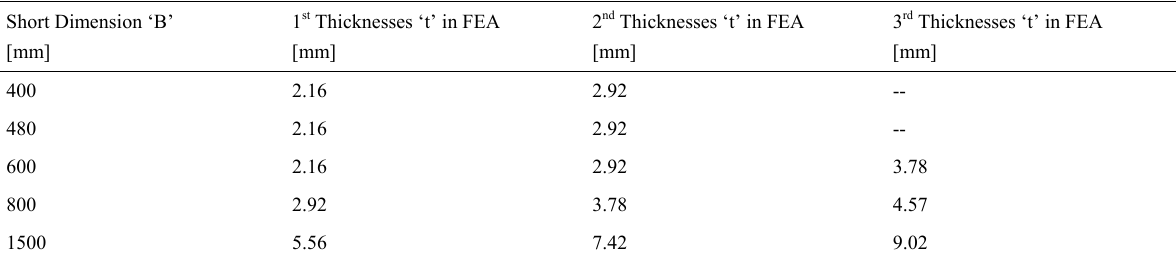
Table 2: Finite Element Model Specimens for Each Aspect Ratio